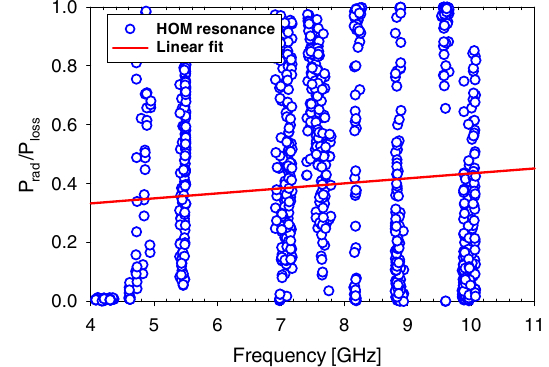
FIG. 11. Resonant excitation of the first monopole band in the 3.9 GHz LCLS-II cavity with 0.3 mA average beam current.